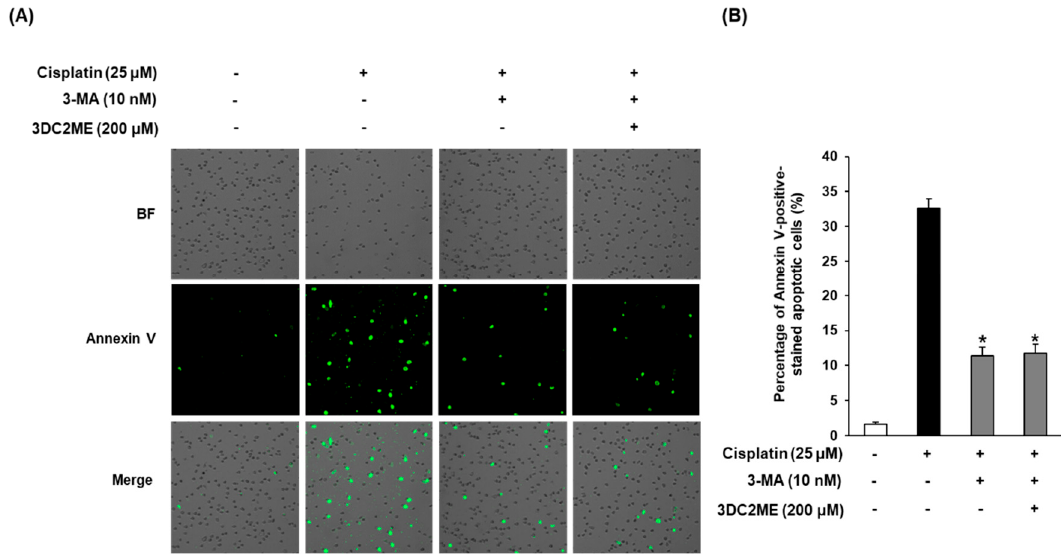
Figure 7. Reduction of apoptosis after treatment of autophagy inhibitor 3-MA and 3DC2ME in LLC-PK1 cells exposed to 25 µ M cisplatin for 24 h. ( A ) Images acquired for quantitative measures of apoptosis and ( B ) percentage of annexin V-positive-stained apoptotic cells. Control cells were treated with vehicle only (mean ± SD, * p < 0.05 compared to control). 3-MA, 3-methyladenine; SD, standard deviation.